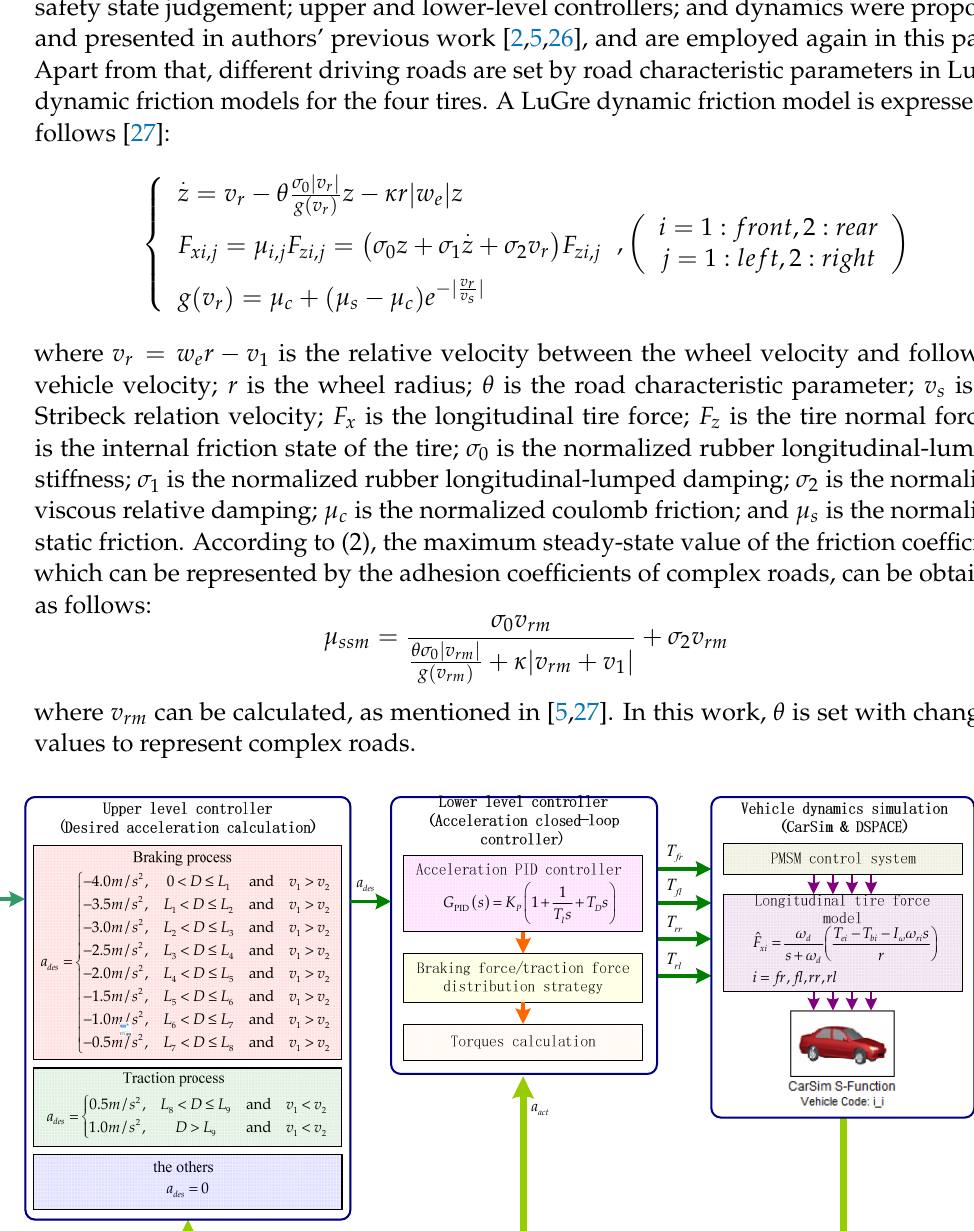
Figure 5. Structure diagram of the active collision avoidance system.